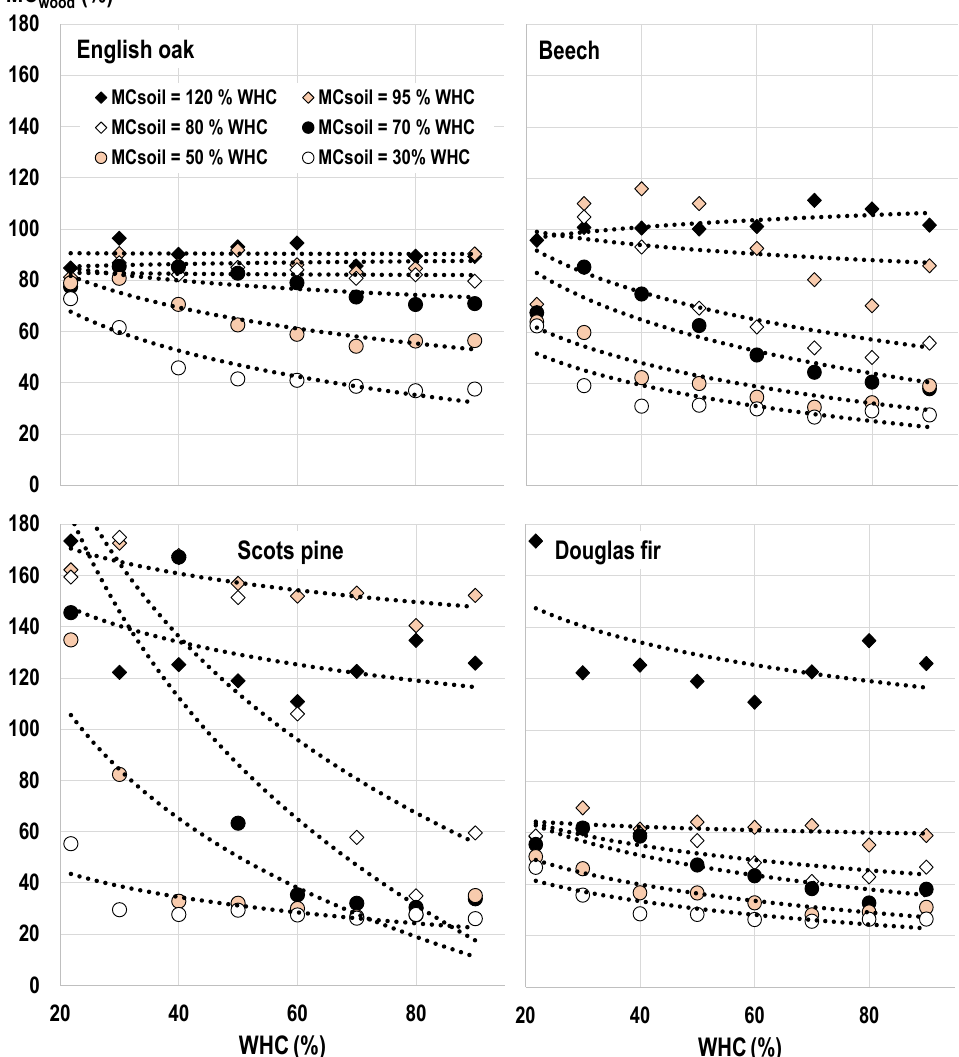
Figure 4. The interrelationship between wood moisture content (MC wood ) and WHC for different MC soil expressed as a percentage of the WHC of the TMC (regression functions are shown in Table 5). Table 5. Regression functions for fitting curves shown in Figure 5 ( y = wood moisture content MC wood ; x = water holding capacity WHC).